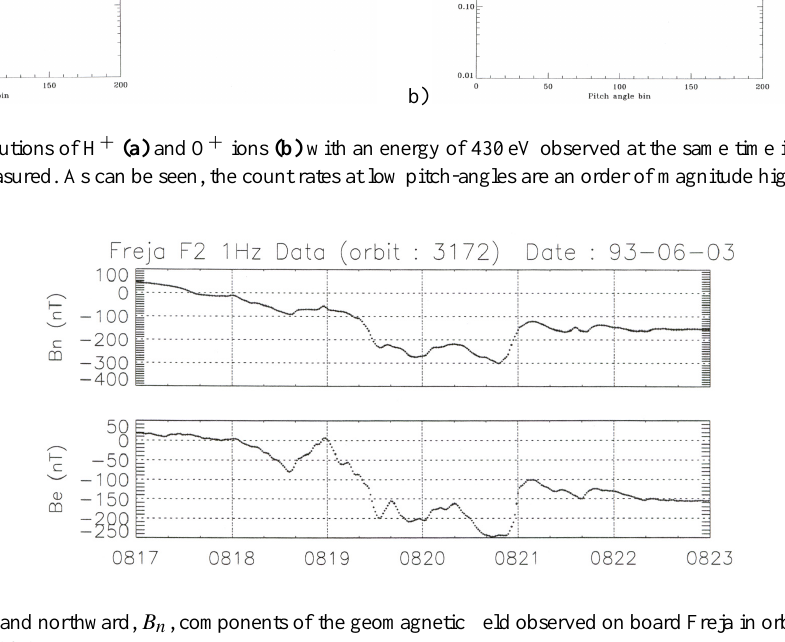
Fig. 5. The eastward, B e , and northward, B n , components of the geomagnetic field observed on board Freja in orbit 3172. The precipitating ions were measured after